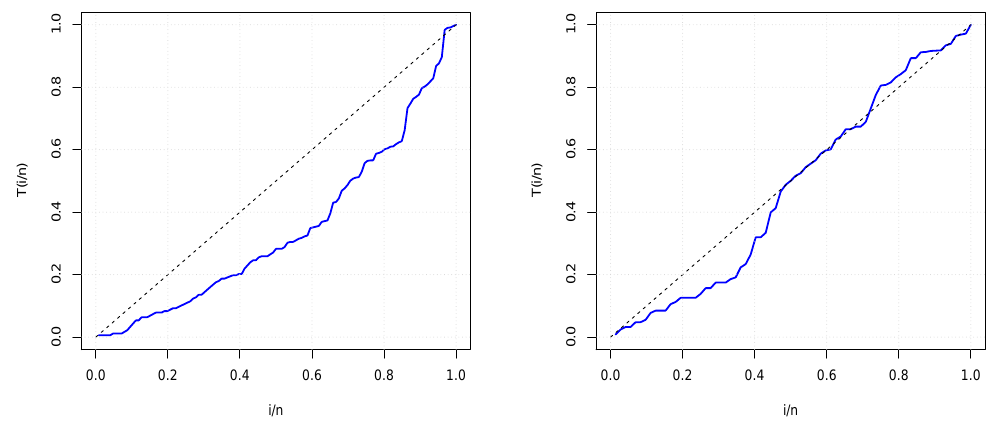
Figure 5. Total time on test (TTT) plots for Data sets I and II, respectively.